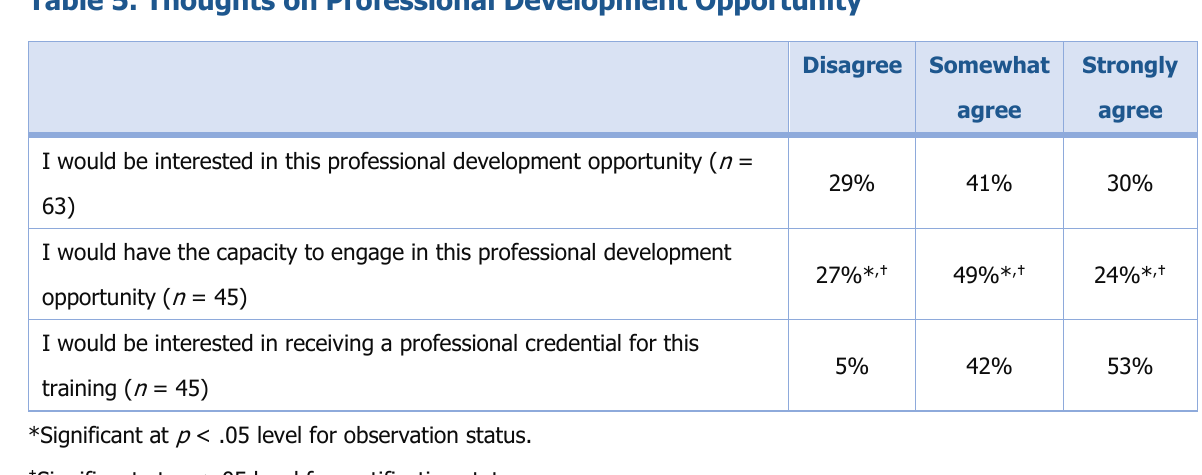
Table 5. Thoughts on Professional Development